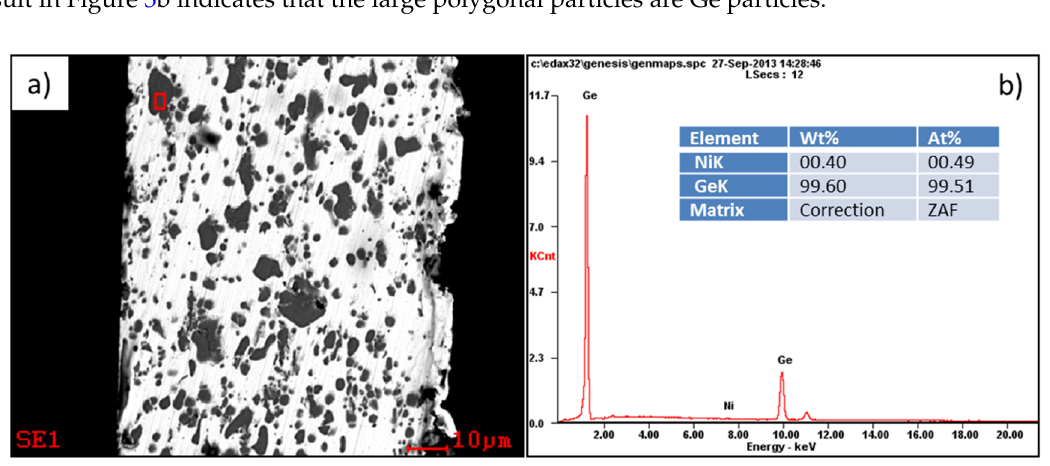
Figure 5. X-ray diffractometer (XRD) patterns of the solder and the solder sintered on Cu-Cr-Zr alloy. Figure 6 displays two inflection points of the DTA curve. It can be seen that the first and the second points are measured to be 368 and 544.4 °C, respectively. Therefore, the melting point of the solder can be determined to be 368 °C. The point at 544.4 °C is related to the melting of Ge-Ni intermetallic particles in the solder. Figure 6. Two inflection points of the differential thermal analysis (DTA) curve, ( a ) the first point and ( b ) the second point.